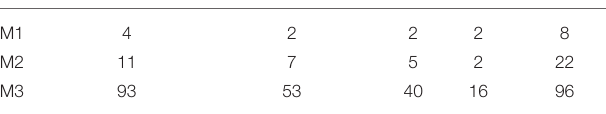
TABLE 2 | Features of the